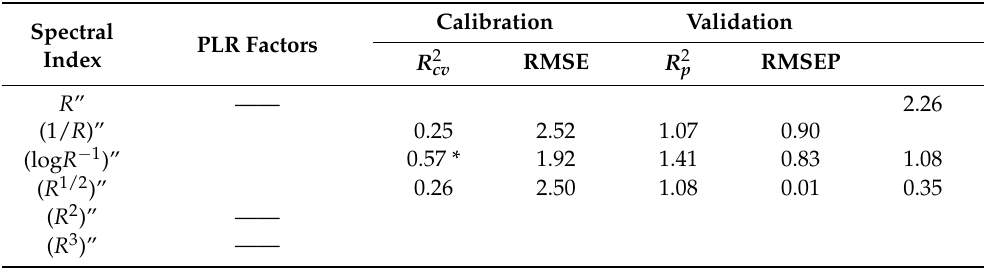
Table 10. Results of partial least squares regression analysis of second-derivate transformation and soil organic matter